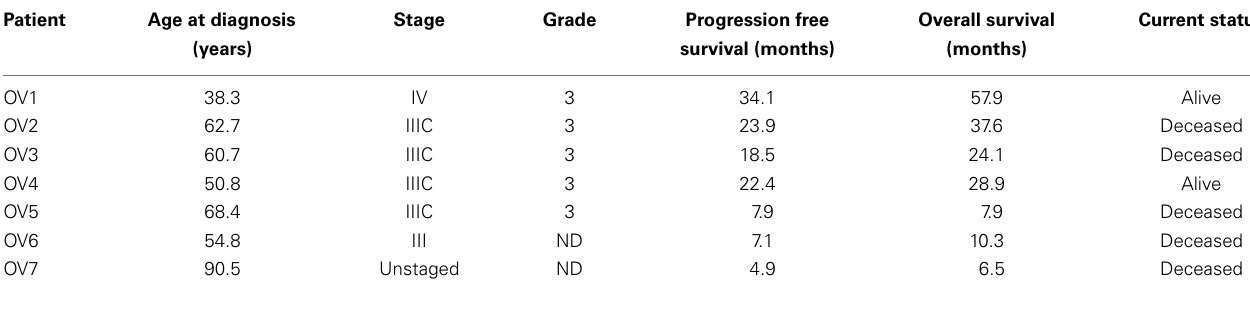
Table 1 | Clinical characteristics of patients whose tumors were analyzed in this study